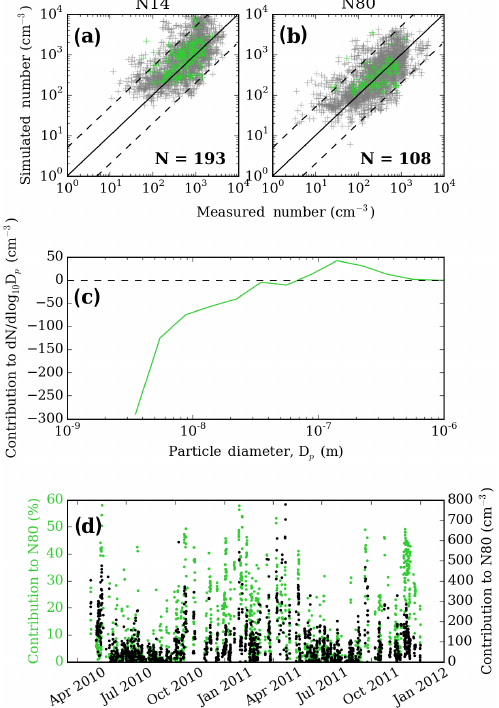
Figure 6. One-to-one plots for measured and simulated (nested res- olution) (a) N14 and (b) N80, where the gray crosses represent all points (implementing the temperature and RH filter), the green crosses represent all points where BASE–noAsia > 50cm − 3 , and the number of points is given by N . (c) The simulated contribu- tion to particle number concentration due to Asian anthropogenic aerosol as a function of particle diameter, D p , averaged over the year when N80 BASE –N80 noAsia > 50cm − 3 . (d) Time series of the percent (green) and absolute (black) contribution to N80 due to Asian anthropogenic